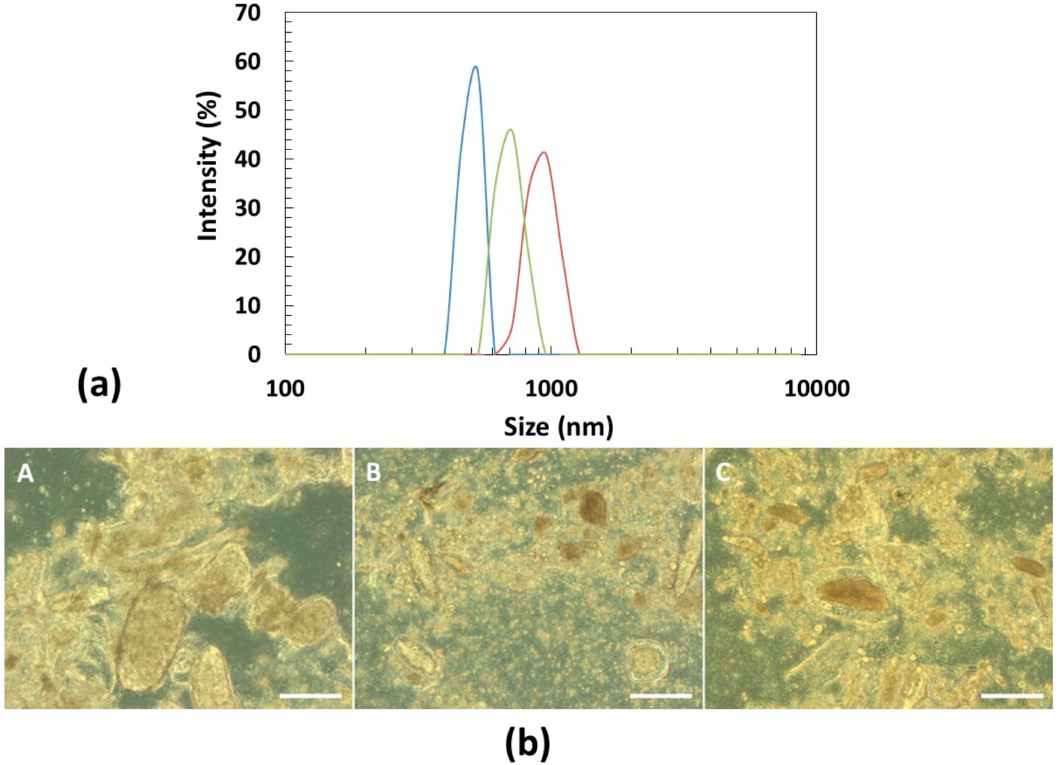
Figure 3. Characterization of the particles from pulse-based beverages with new water (B2): ( a ) particle size distribution of chickpea (blue), lupin (orange) and lupin + chickpea mixture (gray) estimated by dynamic light scattering (Zetasizer); ( b ) optical light microscopy images of chickpea ( A ), lupin + chickpea mixture ( B ) and lupin ( C ). The scale bar represents 100 µ m.